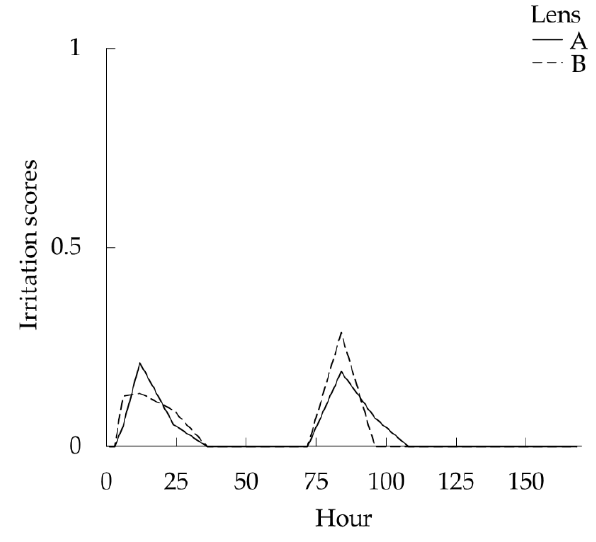
Figure 2. Changes on average irritation scores (ocular discharge) for A and B lenses.